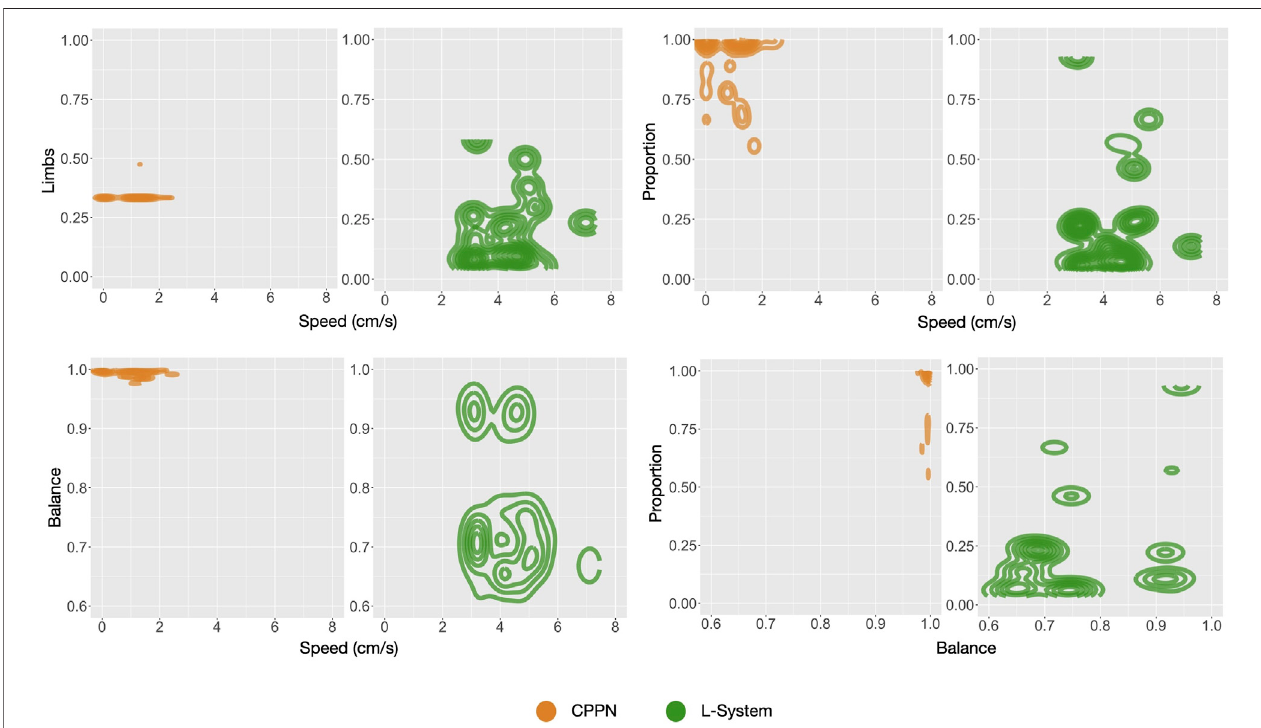
FIGURE 9 | Density of robots for pairs of traits: includes all robots from each fi nal generation (149) of each run all together.